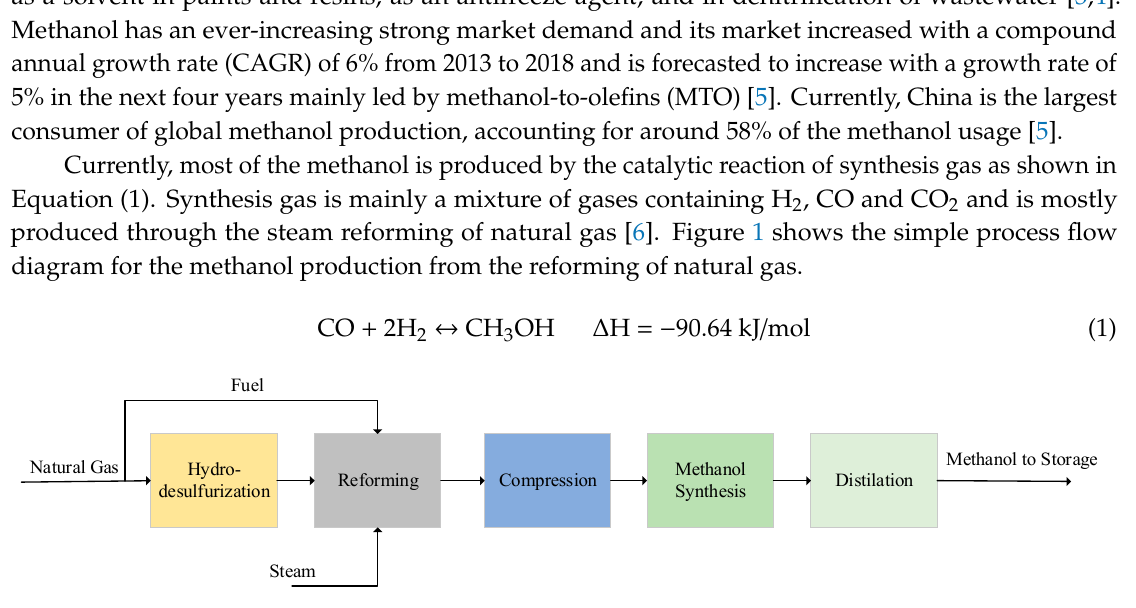
Figure 1. Simplified block flow diagram of the natural gas reforming process for the methanol production.